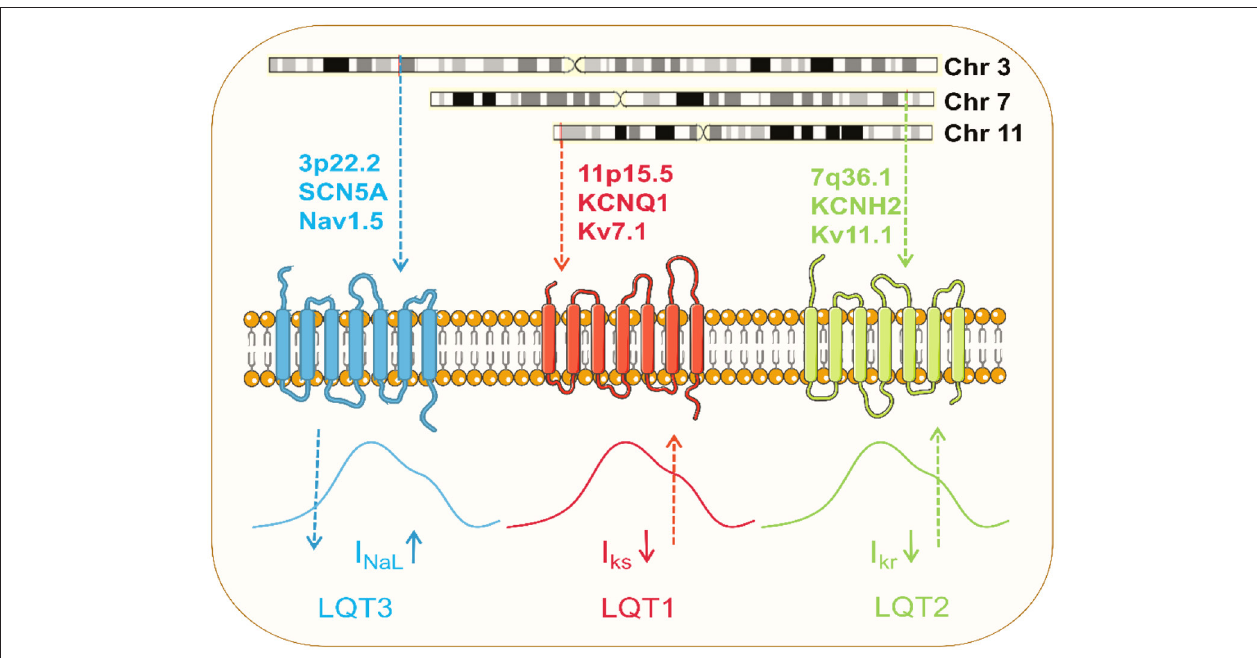
FIGURE 3 | Pathophysiology of the common LQTS. Dominant mutations in KCNQ1 on chromosome 11 and KCNH2 on chromosome 7 result in loss of function of Kv7.1 and Kv11.1 potassium channels, respectively, and these channel currents play a significant role in myocardial repolarization. Pathogenic mutation in SCN5A on chromosome 3 causes gain of function of Nav1.5 channel, resulting in increased late sodium currents to prolong the action